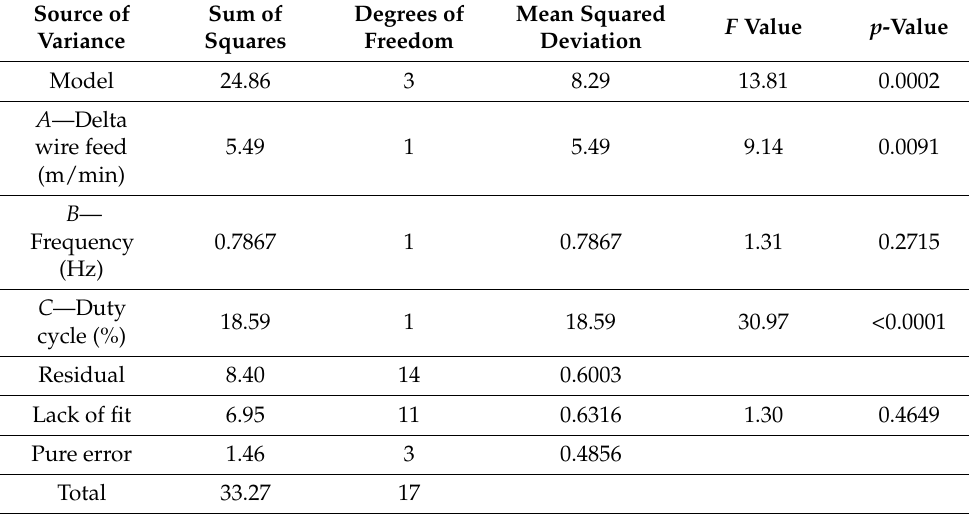
Table 13. Analysis of variance for the regression model–weld width.